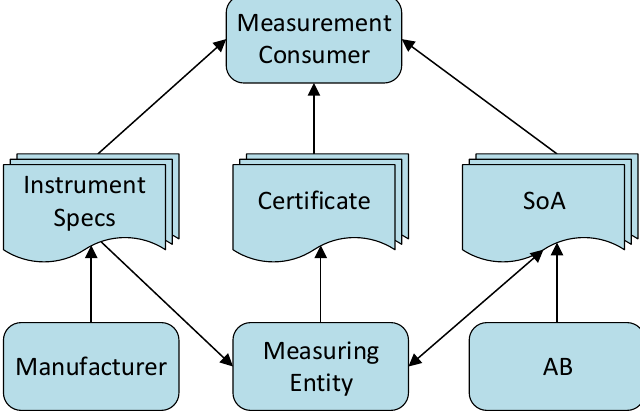
Figure 1. A Partial view of the metrology information